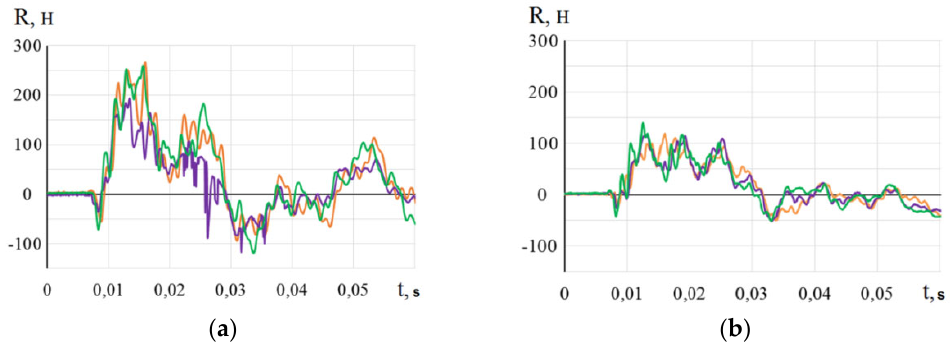
Figure 9. The forces acting on the 1st tube in three experiments with Р 0 (0) = 0.7 MPa; L = 1.0 m: ( a ) the lengthwise pattern; ( b ) checkerboard pattern.